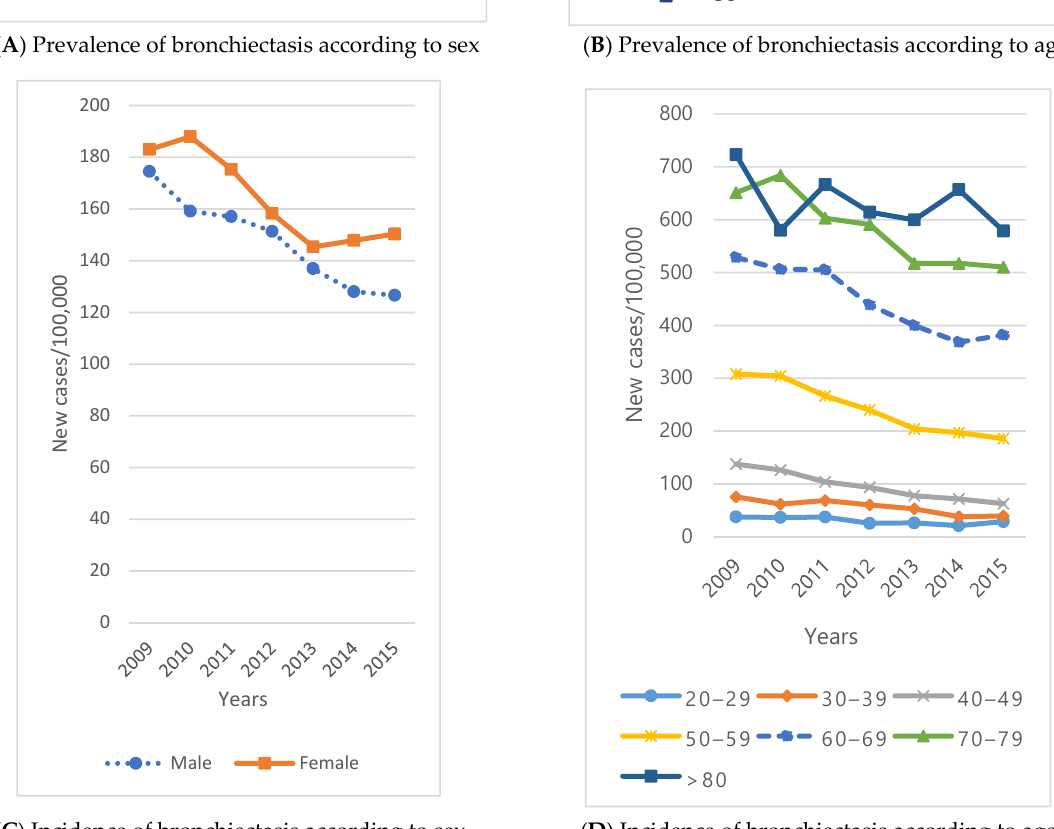
( D ) Incidence of bronchiectasis according to age Figure 2. Temporal trends of bronchiectasis prevalence and incidence by sex and age.